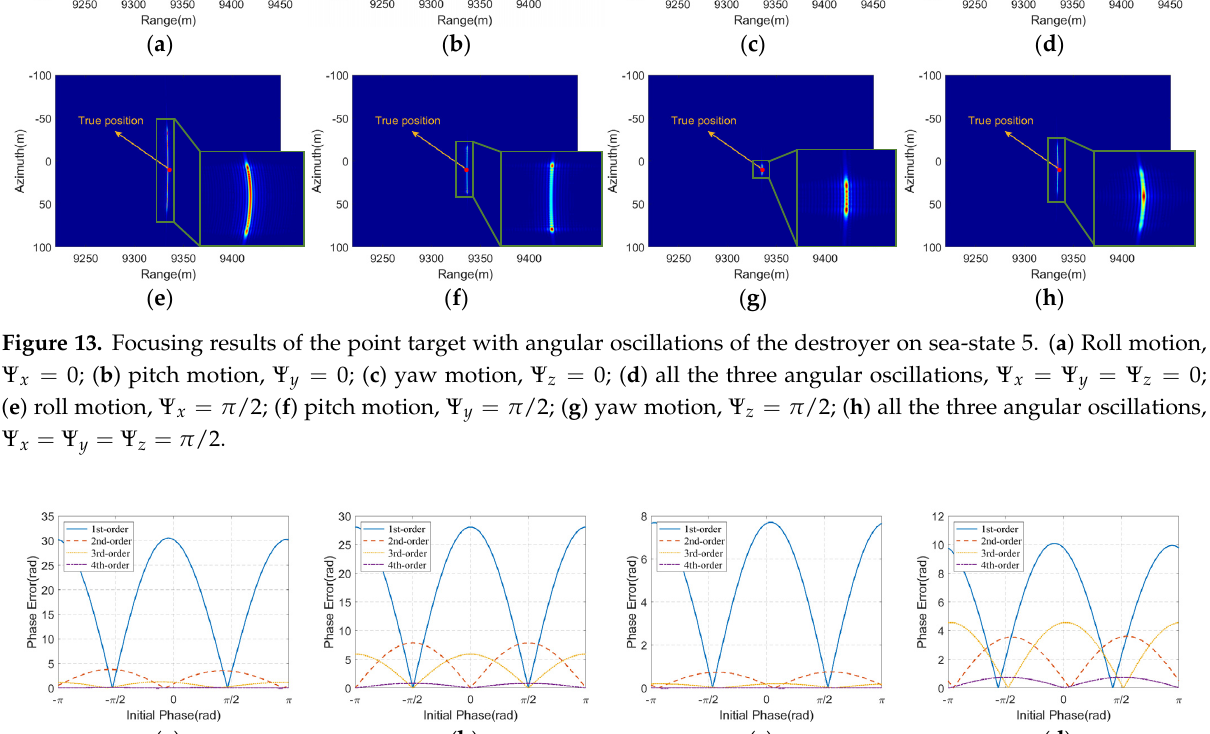
Figure 14. The maximum variation of phase error components introduced by carrier angular oscillation. ( a ) Roll motion; ( b ) pitch motion; ( c ) yaw motion; ( d ) all the three-axis oscillations.